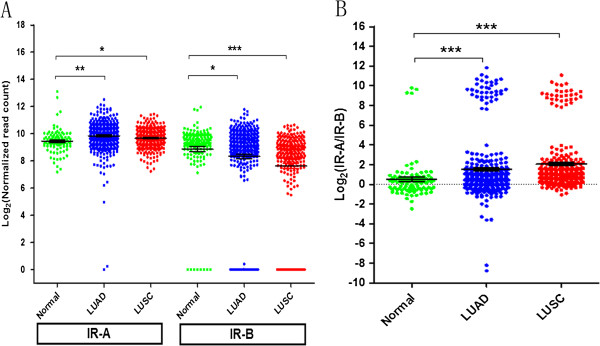
Transcript abundance of insulin receptor isoforms in LUAD and LUSC profiled by TCGA RNA-seq data. A) Log2-transformed and normalized read count of IR-A and IR-B receptor isoforms in LUAD (n = 355), LUSC (n = 259) and adjacent normal tissue (n = 92) and B) the corresponding distribution of log2-transformed IR-A/IR-B mRNA ratio. Asterisks indicate statistically significant differences (* = P < 0.05; ** = P < 0.01; *** = P < 0.001).